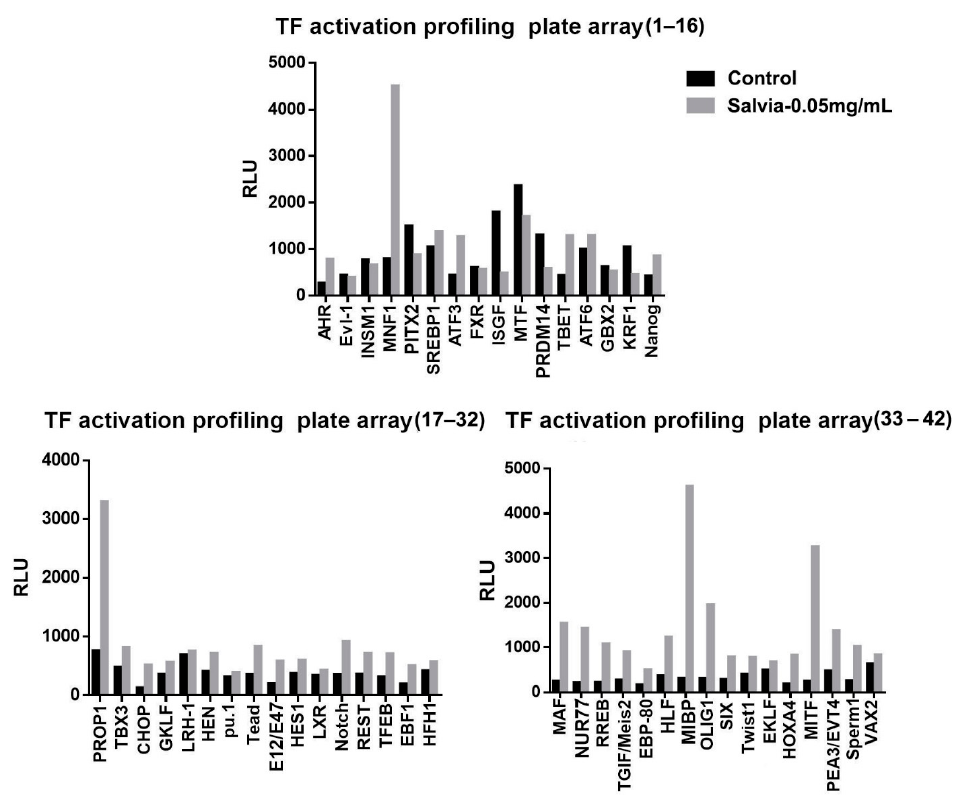
Figure 3. Transcriptomic analysis to identify candidate transcriptional factors in 3T3-L1 cells with or without SME treatment. AHR, aryl hydrocarbon receptor; ATF6, activating transcription factor 6; E12/E47, E2A immunoglobulin enhancer-binding factors; EBF1, early B-cell factor 1; EBP-80, emo- pamil binding protein 80; EKLF, erythroid Krüppel-like factor; Evl-1, myeloid transforming gene;